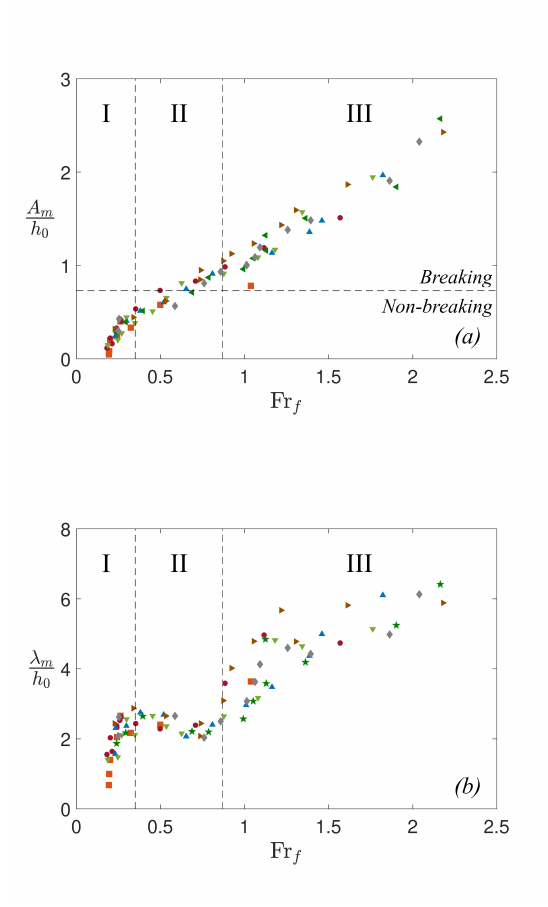
Figure 6. Evolution of (a) the relative amplitude A m / h 0 and (b) the relative mid-height width λ m / h 0 of the wave with the local Froude number Fr f for all our experiments (same data symbols as in Fig. 3). The two vertical dashed lines correspond to the transitions at Fr f = 0 . 35 between nonlinear transition waves (I) and solitary waves (II), and at Fr f = 0 . 87 between solitary waves (II) and hydraulic jumps